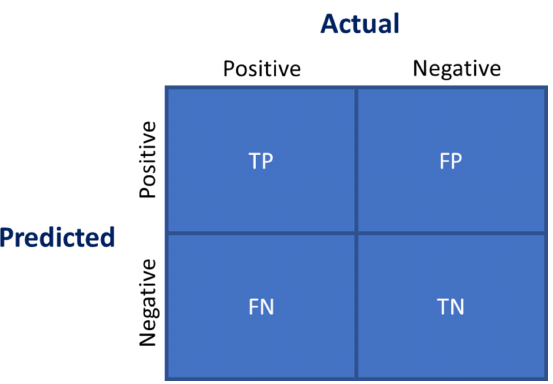
Figure 13. Confusion